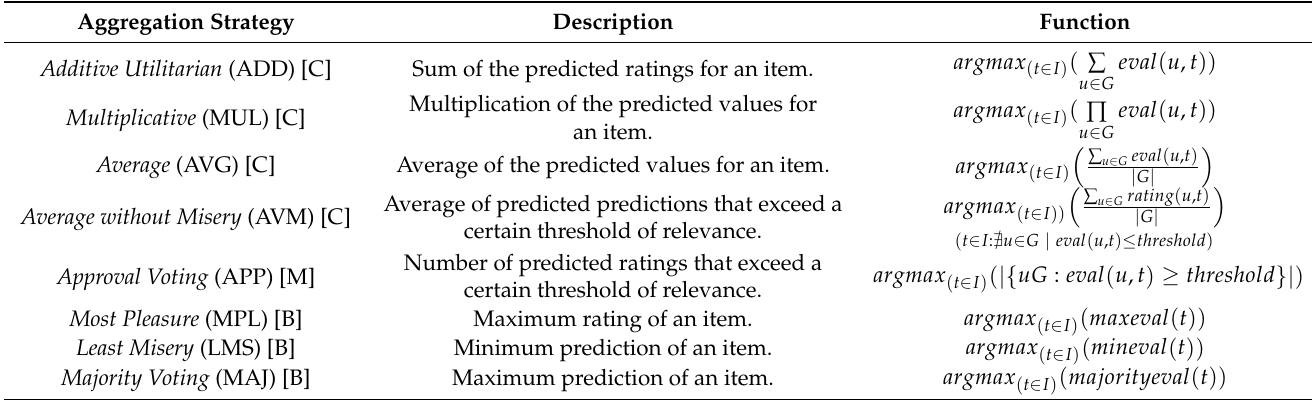
Table 1. Aggregation